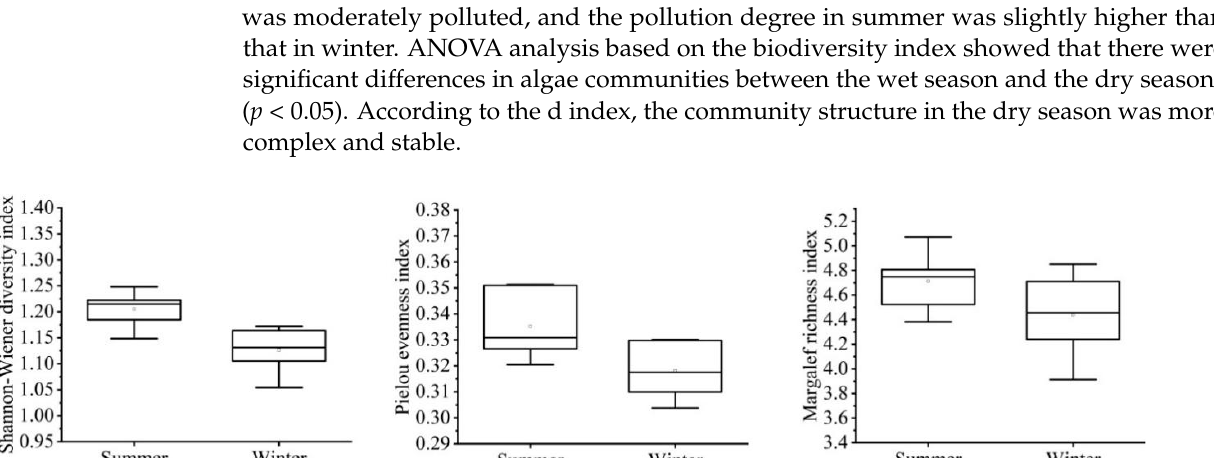
Figure 5. Correlation heat map of periphytic algae and environmental factors in summer ( a ) and winter ( b ).